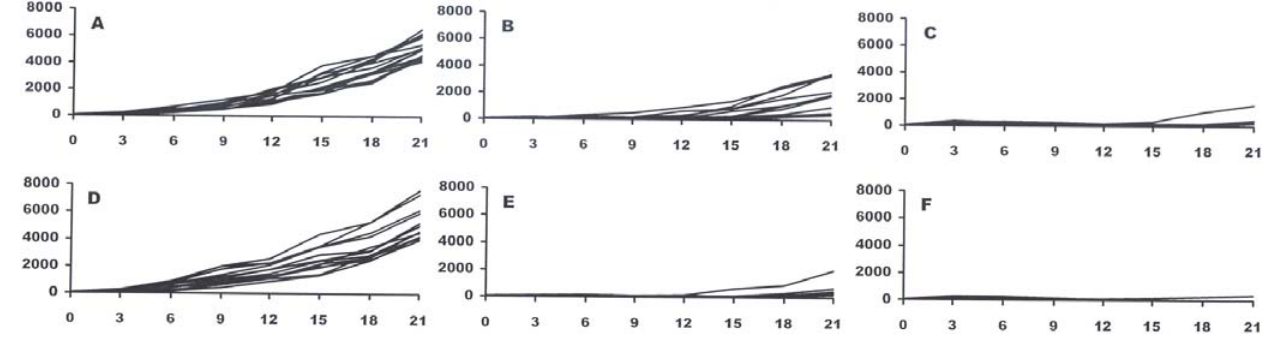
Figure 2. Determination of appropriate electrical parameters for an effective tumor treatment by IRE – experiments with immunodeficient (nude) mice. Panels are identified by letters corresponding to the parameters described in table 1, except for panel A (tumor growth in untreated mice followed as controls of treatment conditions B and C) and panel D (control of treatments E and F).